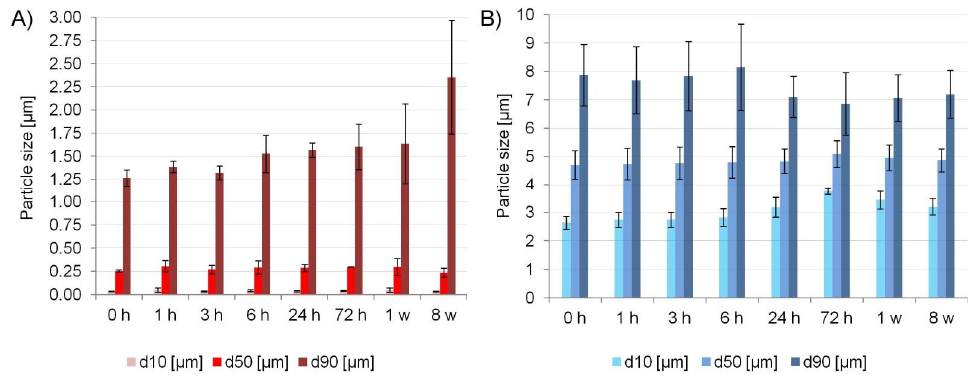
Figure 9. Particle size distribution stability of nanosuspensions ( A ) and microsuspensions ( B ).